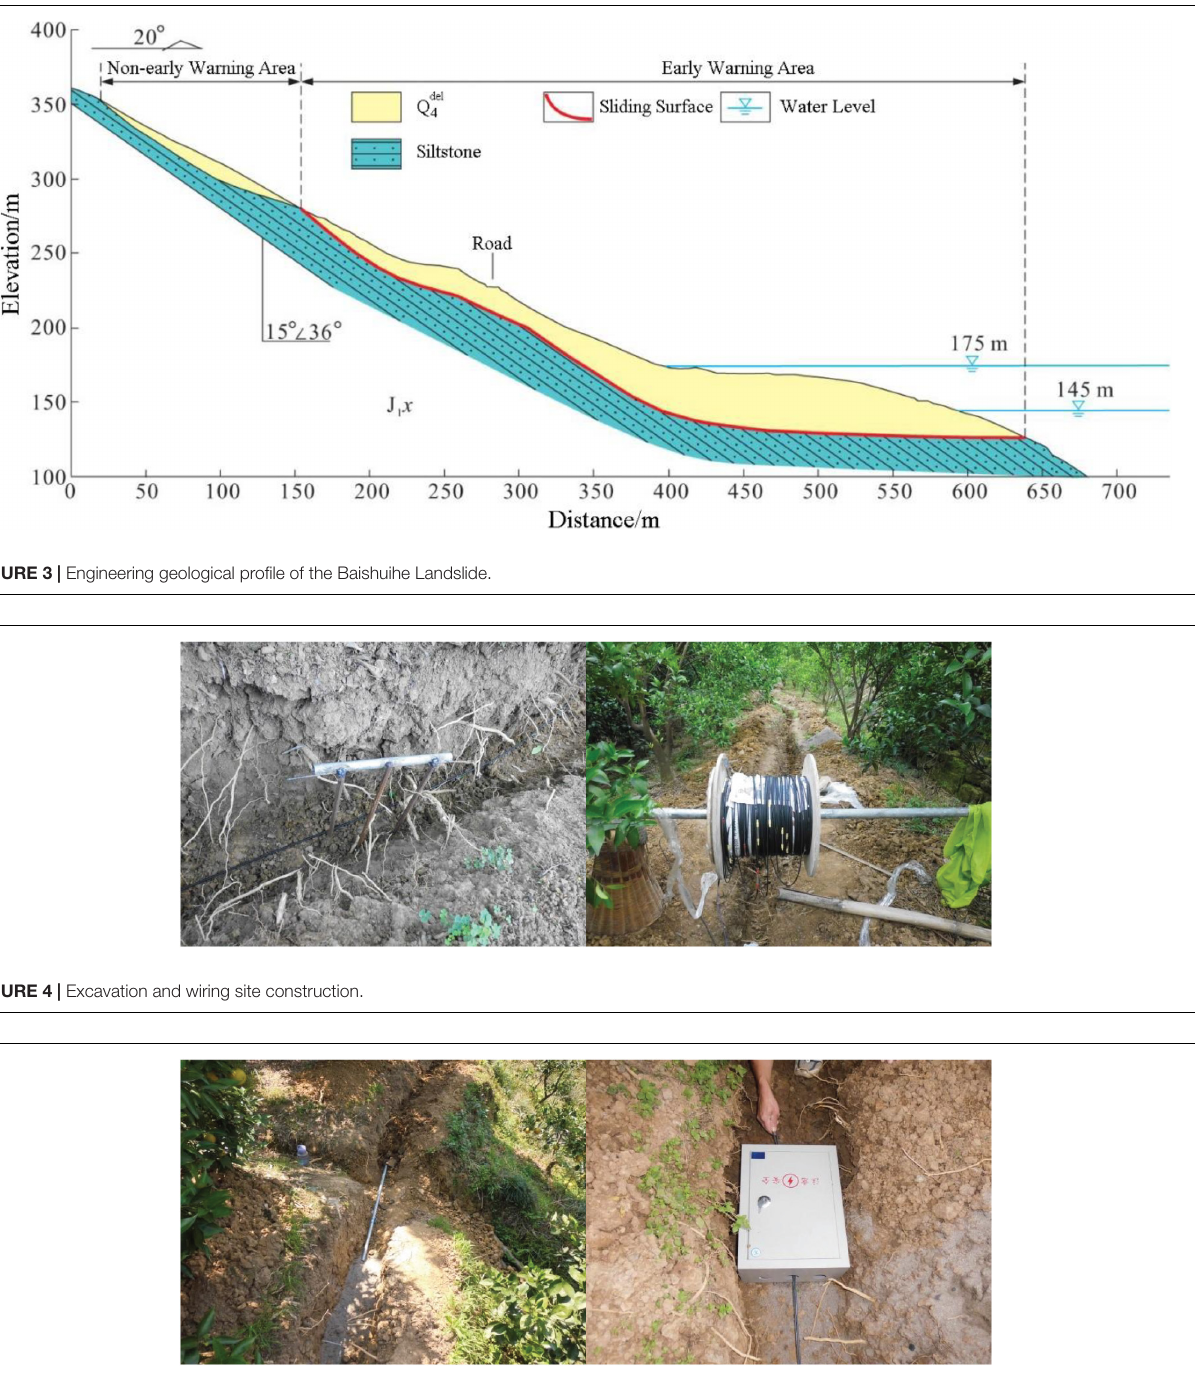
FIGURE 5 | Backfilling site